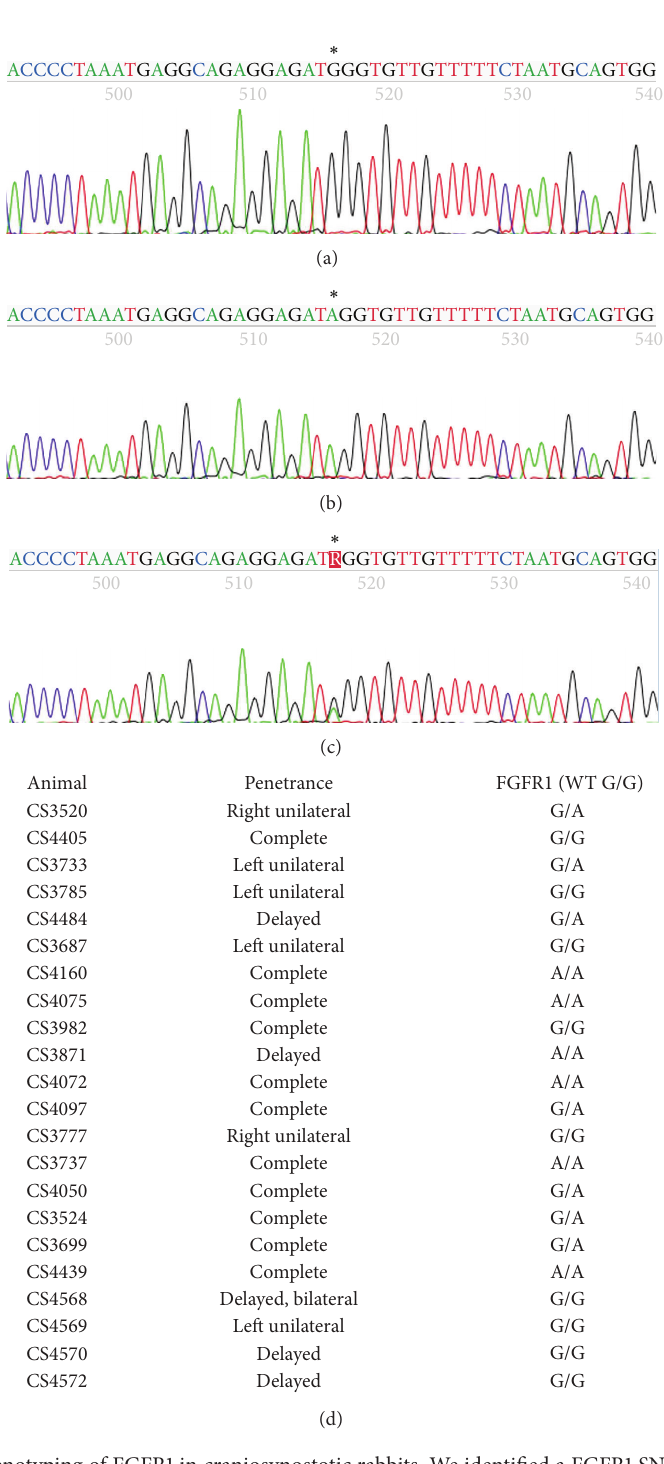
Figure 3: SNP discovery and genotyping of FGFR1 in craniosynostotic rabbits. We identified a FGFR1 SNP within intron 8 that segregates independently of craniosynostosis within our colony, ruling out FGFR1 as the causative agent. ((a)–(c)) Sequencing traces representing G/G (a), A/A (b), or G/A (c) genotypes from CS genomic DNA. (d) Results of sequencing of 22 randomly selected CS animals; nine animals were G/G, six animals were A/A, and seven animals were